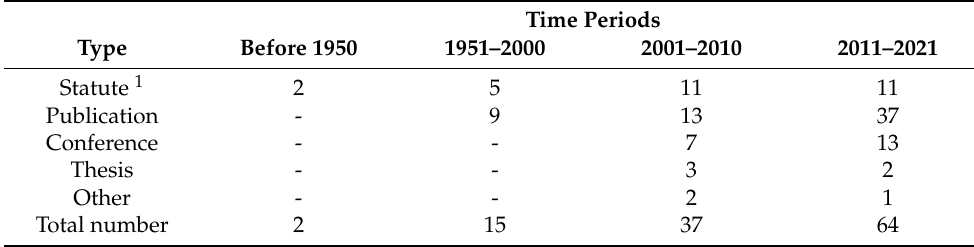
Table 2. Literature time periods per source